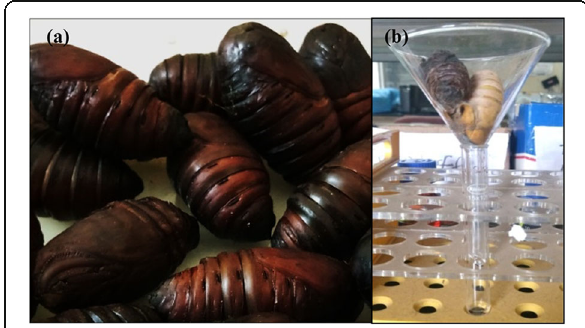
Fig. 14 Identified suitable stage of pupae for cocoonase collection based on change in integument color ( a ) and collection of cocoonase enzyme setup ( b